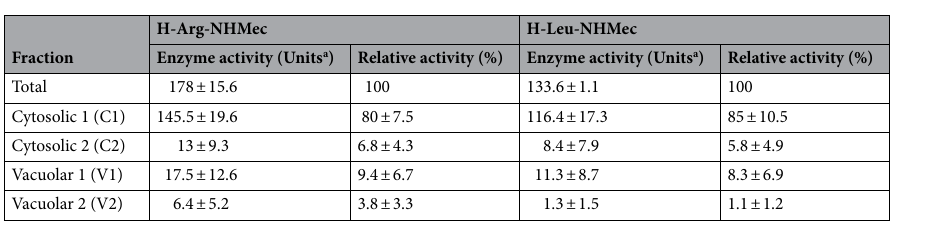
Table 1. Relative distribution of aminopeptidase activity in the P. falciparum cellular fractions (C1, C2, V1 and V2) calculated from a standard curve prepared using free NMMec. a One unit of enzyme is defined as the nanomoles of NHMec released per 30 min at 37